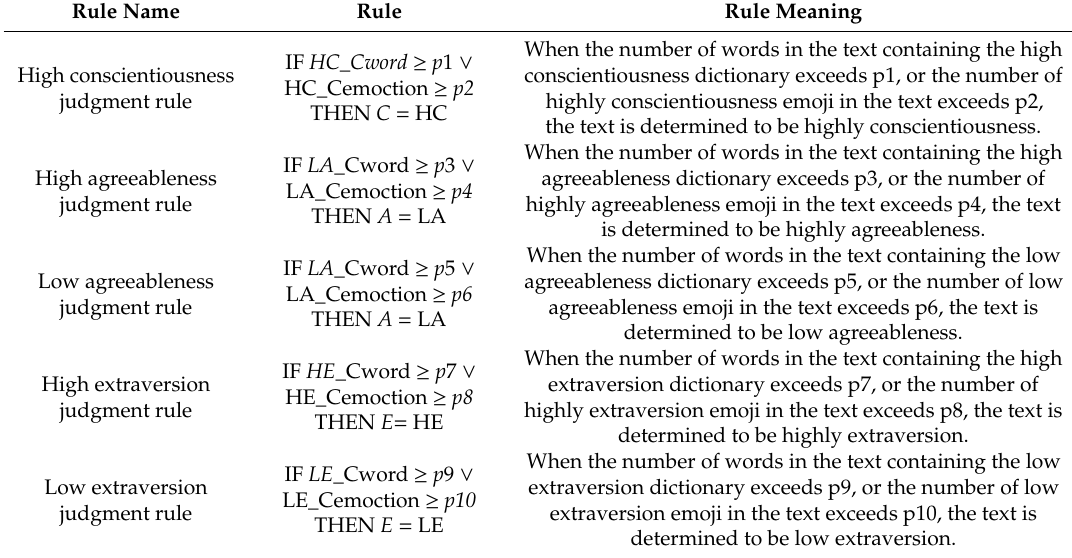
Table 2. Rule of personality